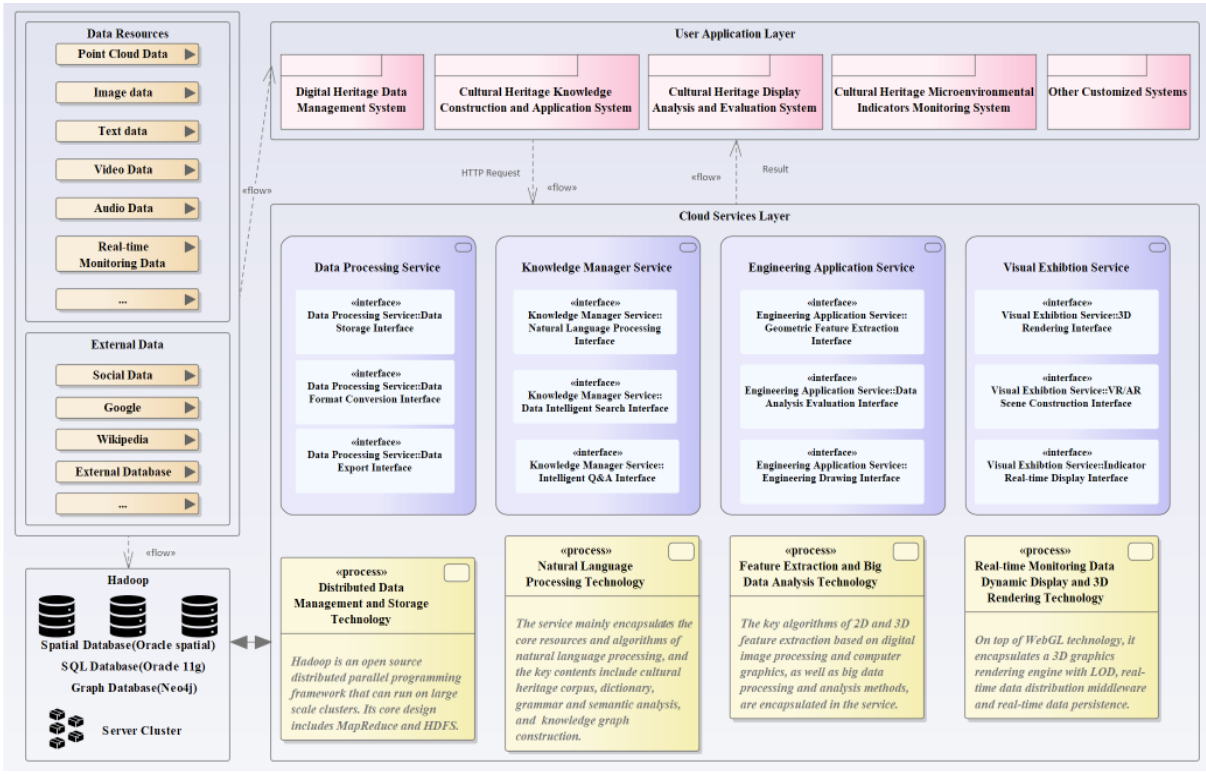
Figure 3. Digital heritage cloud platform implementation architecture